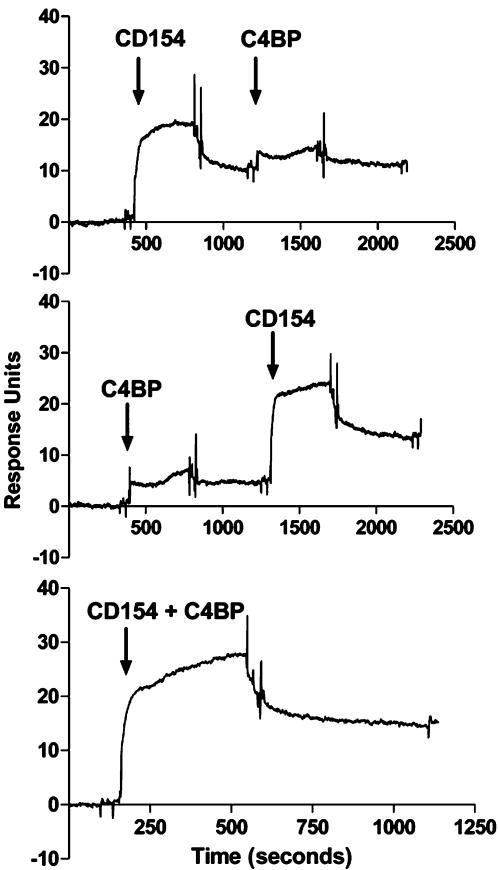
Surface Plasmon Resonance (Biacore) analysis – This figure shows the sensogram for interactions between immobilised CD40, sCD154 (10 ug/ml) and C4BP (40 ug/ml). The human CD40 fusion protein was immobilised onto an activated CM5 chip and sCD154, C4BP or a mixture of both was flowed across the surface of the chip in various combinations allowing adequate time for both association and dissociation events. The chip was regenerated using between experiments using 2 M glycine. Any change in surface plasmon resonance due to binding of the soluble proteins to the immobilised CD40 was seen as a change in response units on the sensogram.